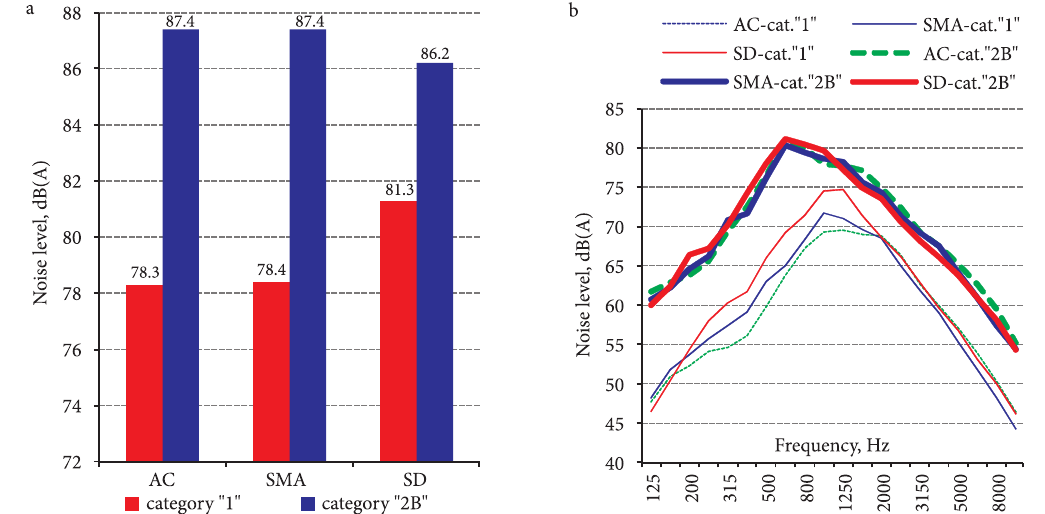
Fig. 3. Noise level (a) and tyre/road spectrum (b) obtained for statistic passenger car (cat.”1”) and multiple-axle heavy vehicle (cat.”2 B ”) on tested three pavements (speed V 1 =V 2 B = 80